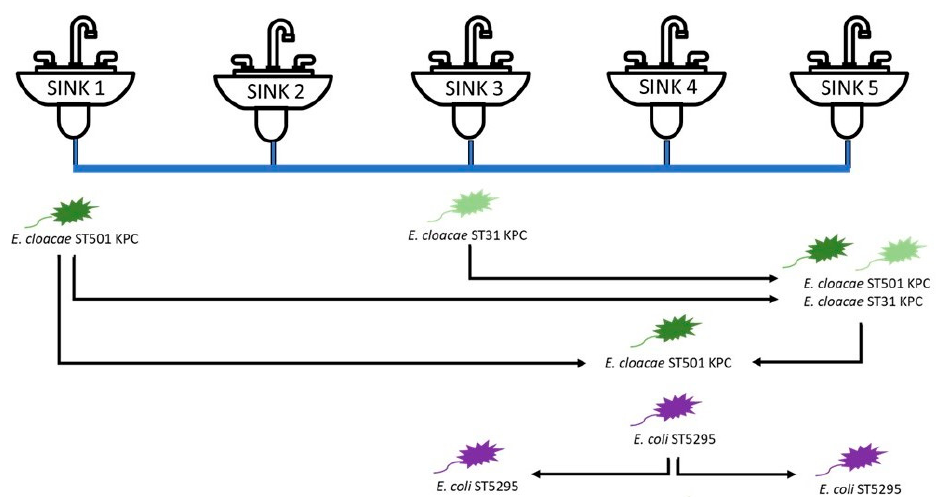
Figure 2. Schematic representation of transfer events involving sinks positioned in line sharing a common wastewater pipe in a laboratory model system.